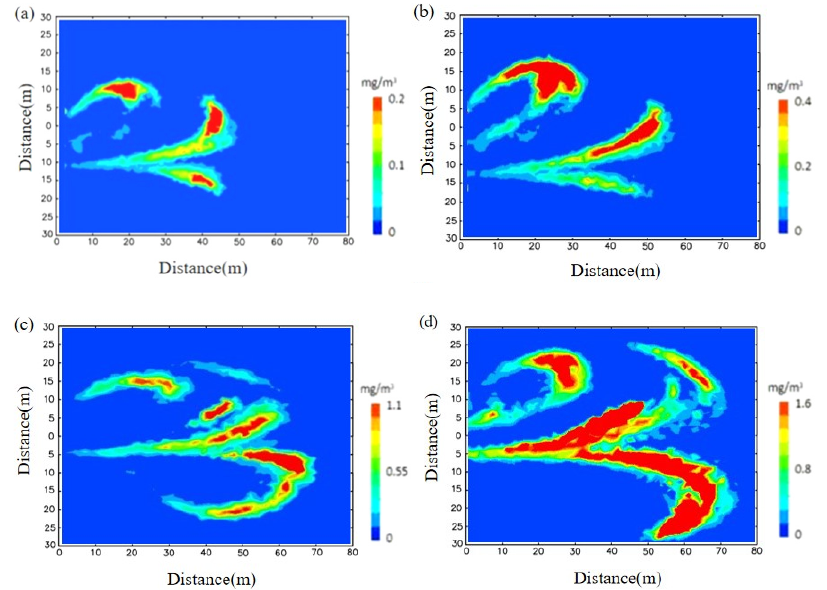
Figure 7. PM concentration profiles at horizontal direction at 1.5 m heights by CFD technology: ( a ) PM 1 ; ( b ) PM 2.5 ; ( c ) PM 10 ; and ( d ) TSP (outside).